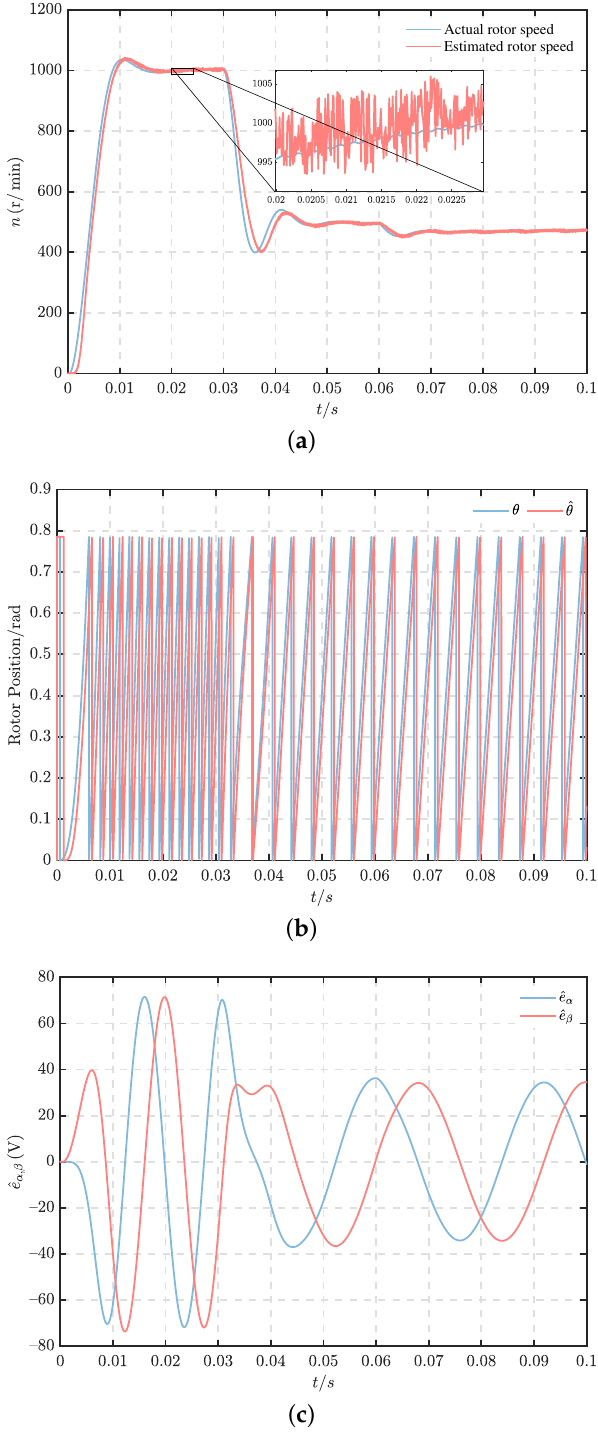
Figure 13. Responses of simulation with conventional SMO combined with conventional PLL (dynamic). ( a ) Rotor speed. ( b ) Rotor position. ( c ) Estimation of the